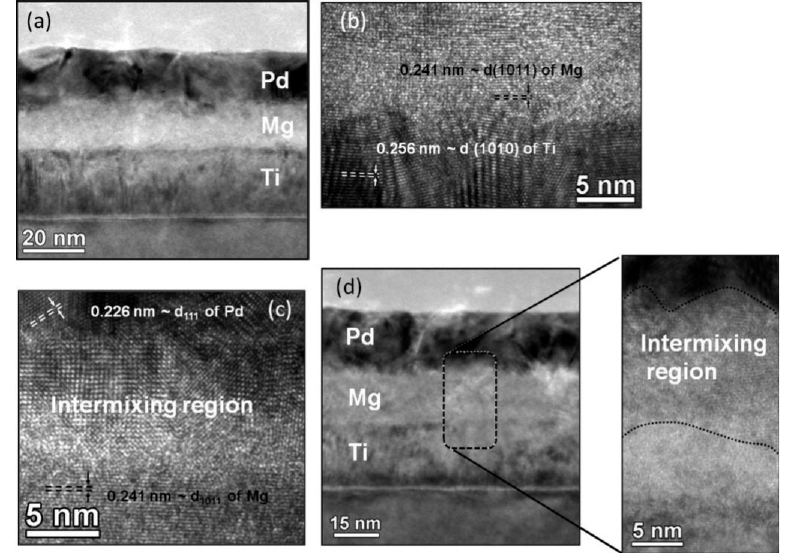
Figure 10. ( a ) Cross-section TEM image of as-deposited Ti/Mg/Pd multilayer samples; ( b ) High Resolution TEM (HRTEM) image of the Ti/Mg interface in ( a ); ( c ) HRTEM image of the Mg/Pd interface in ( a ); ( d ) Cross-section TEM image and HRTEM of annealed Ti/Mg/Pd sample. The dashed area highlights the intermixing region. Reprinted with permission from Ref. [68]. Copyright 2012 American Physical